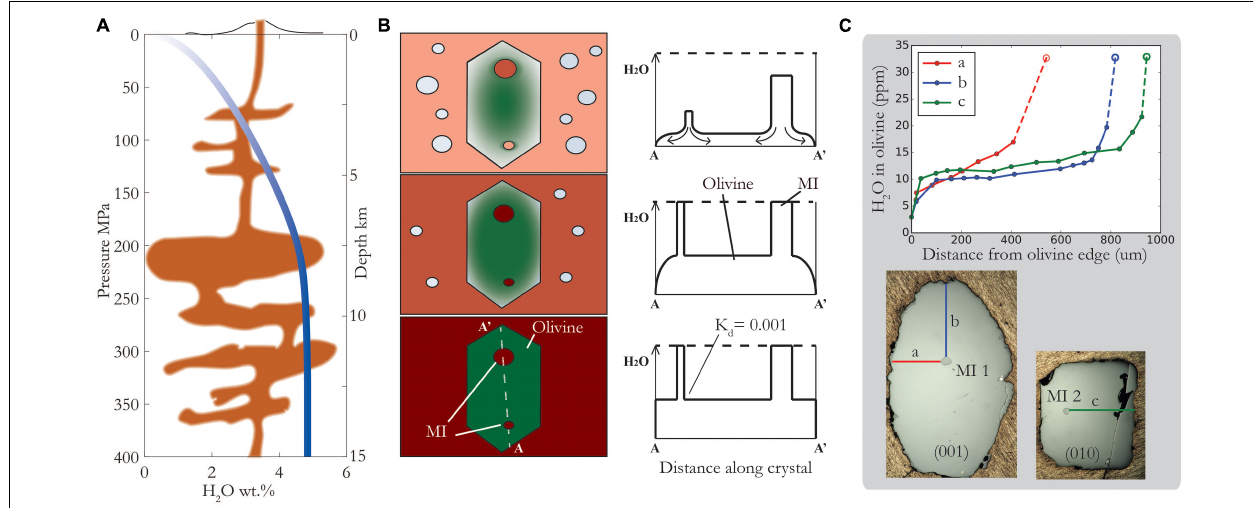
FIGURE 1 | Schematic showing magma ascent, degassing and re-equilibration of melt inclusions (MIs). (A) Closed system degassing of H 2 O from Witham et al. (2012) SolEx model for Cerro Negro basaltic composition with 4.75 wt% initial H 2 O. Depth shown for illustrative purposes, assuming density of 2.7 g/cm 3 (B) Schematic showing how diffusion profiles progress from the outside to the inside of the crystal during ascent, eventually reaching MIs and causing them to lose H 2 O. Smaller MIs will lose water faster than larger MIs. Partition coefficient, K d , is ratio of H 2 O in olivine relative to melt. (C) Diffusion profiles measured by SIMS in olivine along each of its crystallographic directions – see reflected light photos below of same crystal, polished along different sections, containing two different MIs-1 and -2 with similar H 2 O concentrations, 3.26 and 3.29 wt%, respectively. Right photo shows only half the olivine crystal – the left edge is a fracture. Dashed lines and open symbols illustrate the calculated H + concentration in equilibrium with measured MI concentration assuming a partition coefficient of 0.001. Note that a profile is different to b and c profiles, consistent with strong anisotropy of diffusivity: Da > 10x Db, Dc (see text for